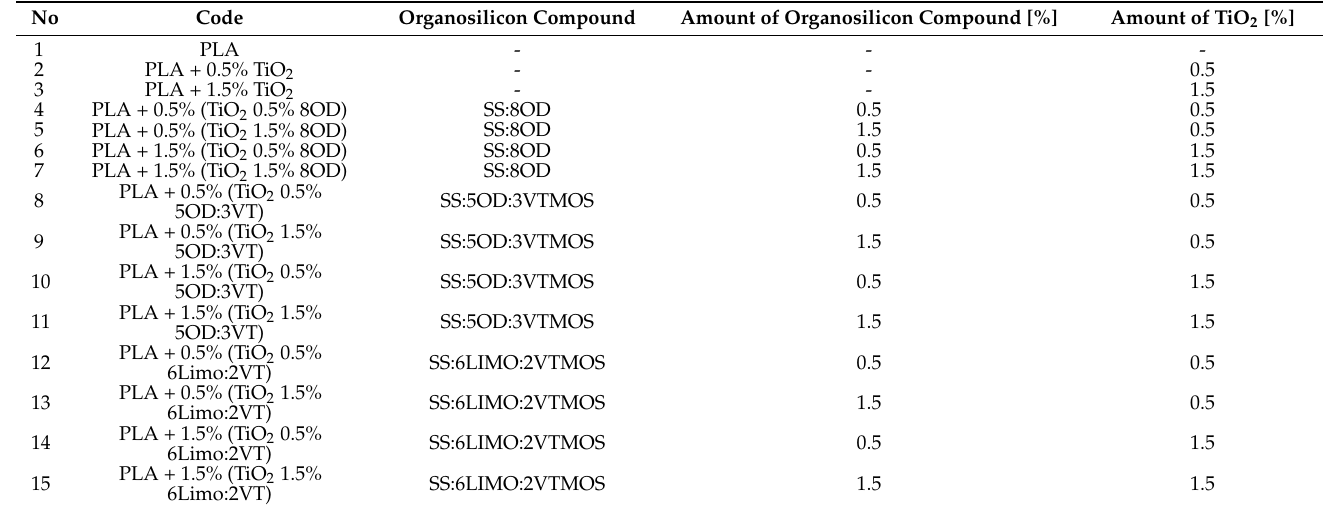
Table 1. Contents of PLA/TiO 2 /modifiers composites.